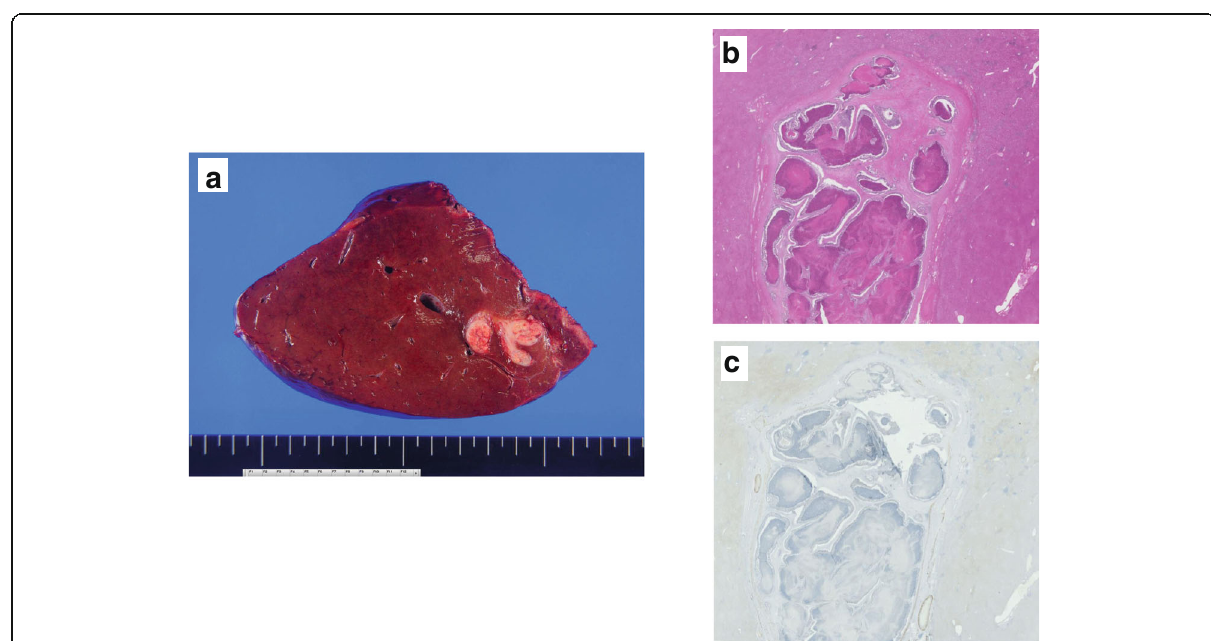
Fig. 4 Images of the resected specimen. a The tumor did not invade the hepatic parenchyma. b Venous infiltration was found in the specimen on hematoxylin and eosin staining (loupe). c Tumor thrombosis did not invade the liver parenchyma on desmin staining